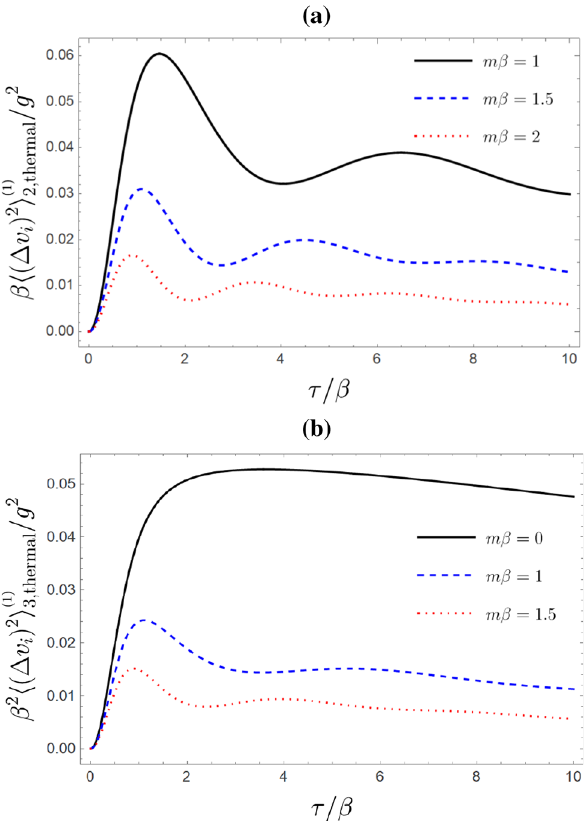
Fig. 2 Velocity dispersions caused by a thermal bath for different val- ues of the mass with fixed n = 20. a Dispersions for D = 2. b Disper- sions for D = 3. As for D = 3 the massless limit is well-behaved, no oscillations appear in this